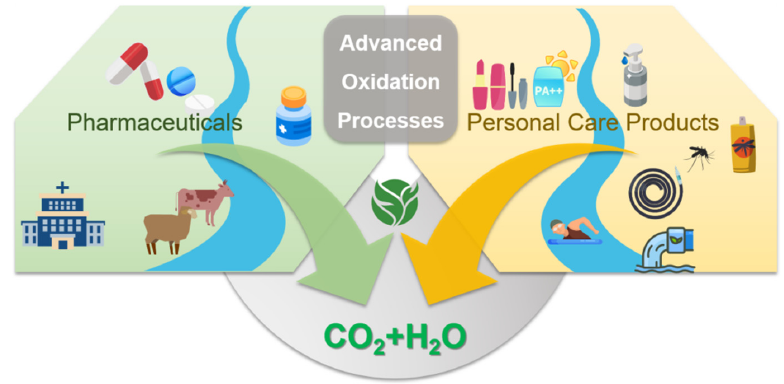
Figure 3. The illustration of the removal of PPCPs by free radicals in AOPs.